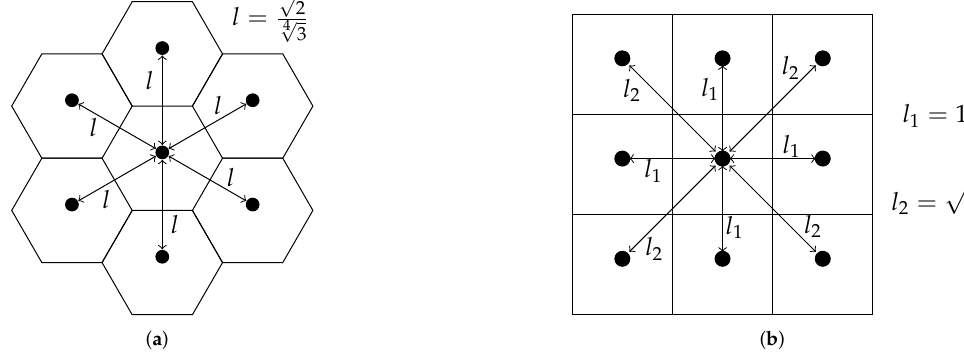
Figure 5. Comparison of the neighborhood for square and hexagonal lattice. Distances given when area of polygons is one. ( a ) The distance to all neighbors is the same at approximately 1.07. ( b ) There are two types of neighborhood. Avarage distance to the neighbor is approximately